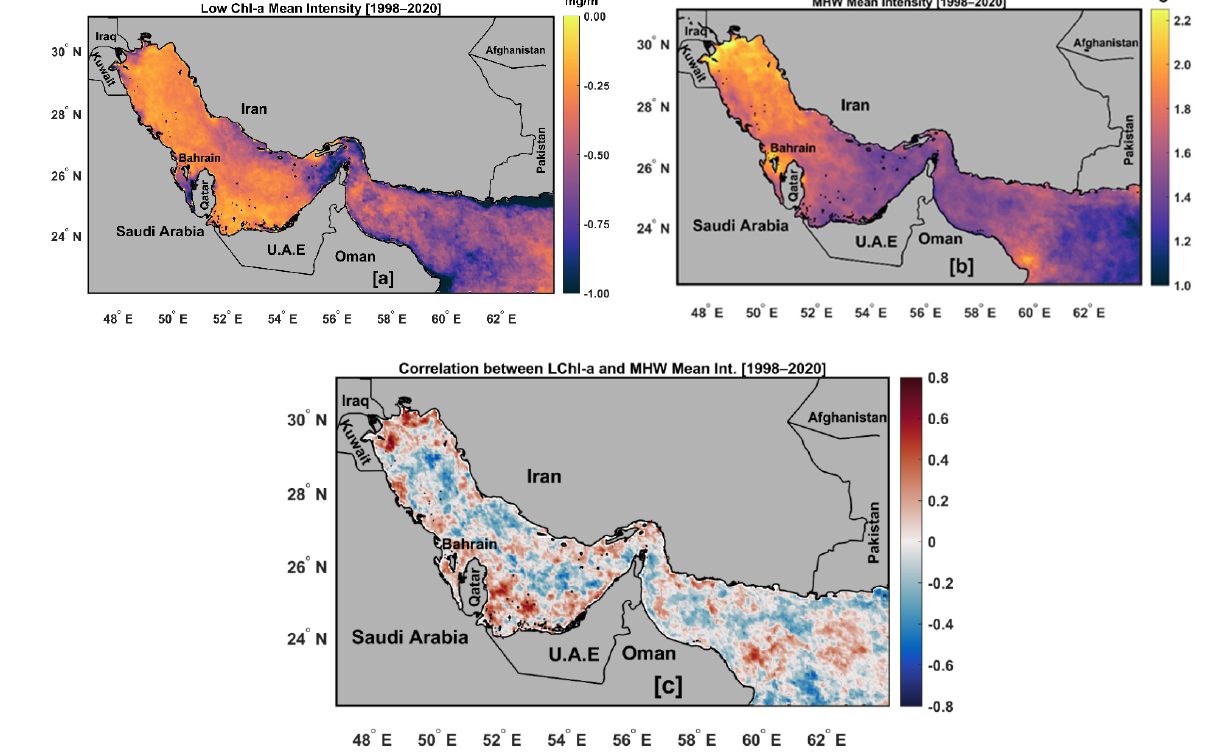
Figure 6. Time series anomalies of SST (red line) and Chl-a concentration (green line) for ( a ) the Arabian Gulf and ( b ) the Gulf of Oman between 1998 and 2020.